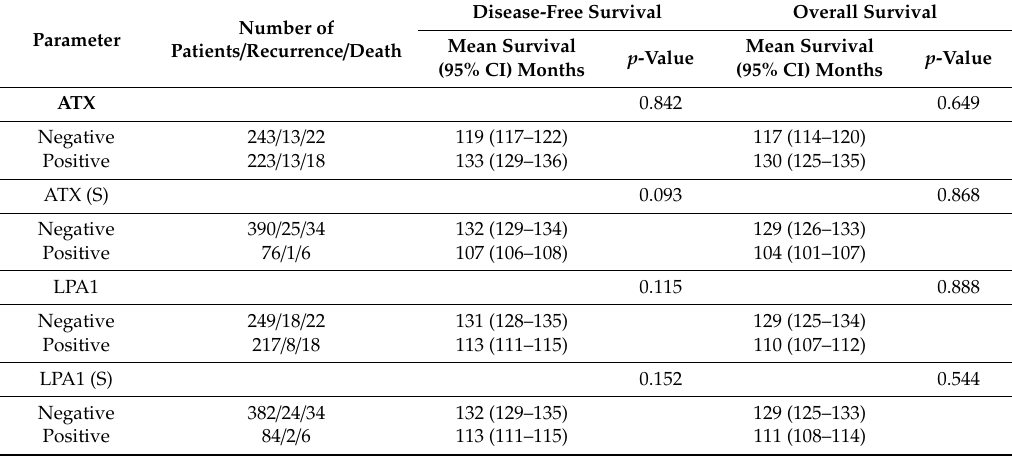
Figure 5. Disease-free survival and overall survival according to LPA3 expression in breast cancer with adipose stroma. In breast cancer with adipose stroma and ER-negative breast cancer, LPA3 positivity ( a ) and stromal LPA3 negativity ( b ) are associated with shorter disease-free survival, and LPA3 positivity is associated with shorter overall survival (OS) ( c ). LPA3 positivity is associated with shorter OS in breast cancer with adipose stroma and PR-negative breast cancer ( d ). Green, censored LPA3(S) positive patients; blue, censored LPA3 negative patients Table 7. Univariate analysis of the impact of expression of ATX-LPA signaling-related proteins in breast cancers on disease-free survival and overall survival by the log-rank